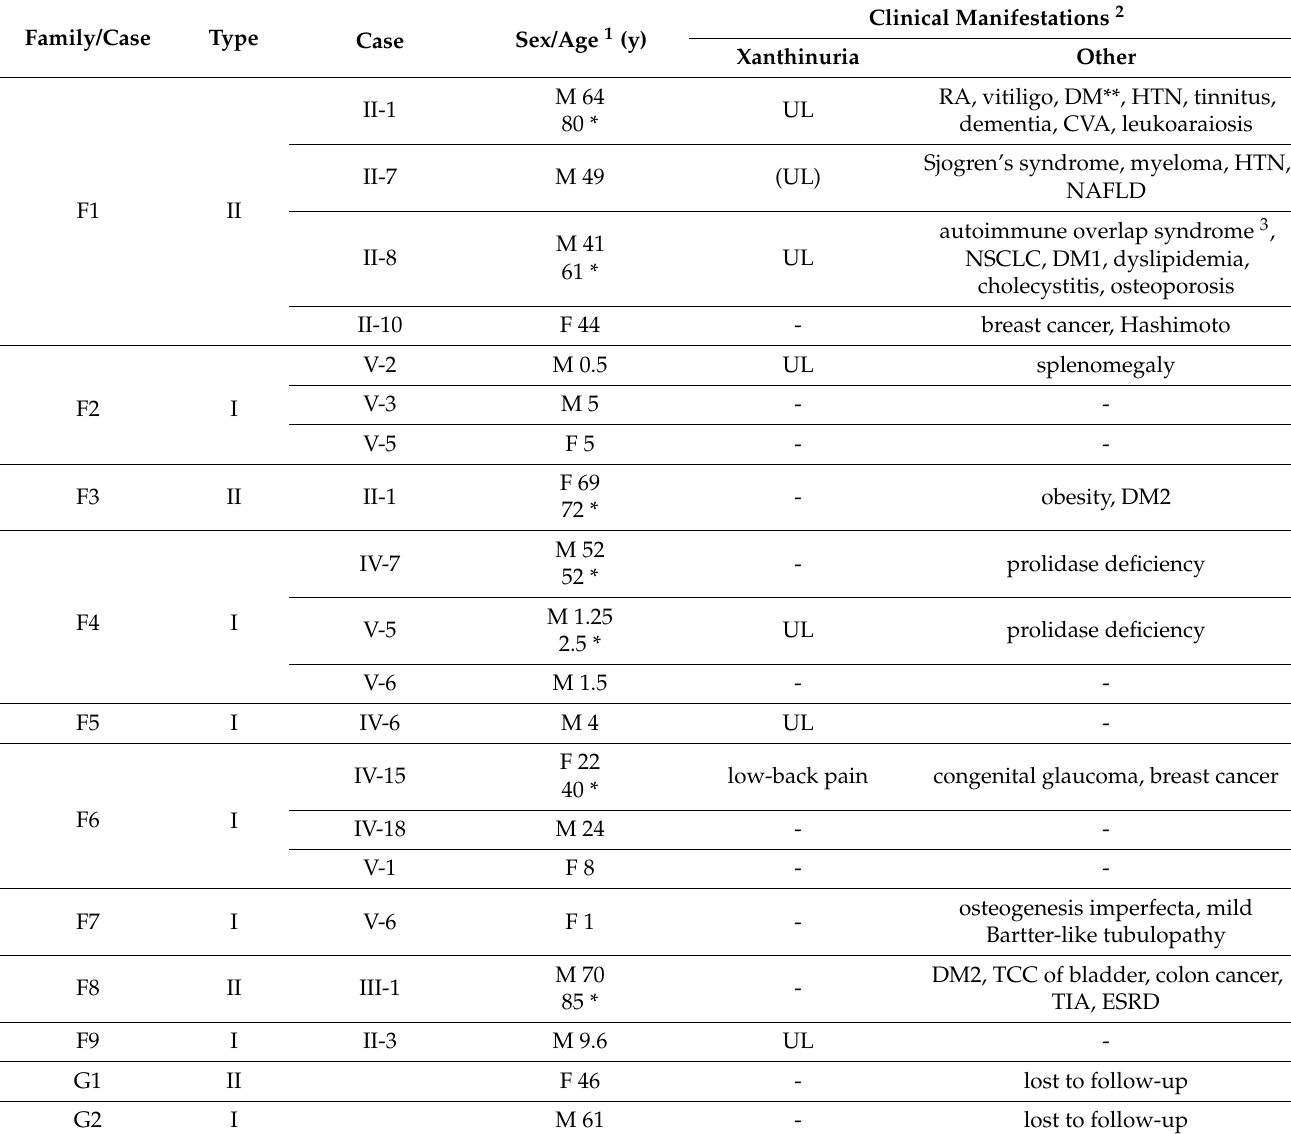
Table 1. Clinical findings in 20 subjects affected by classical